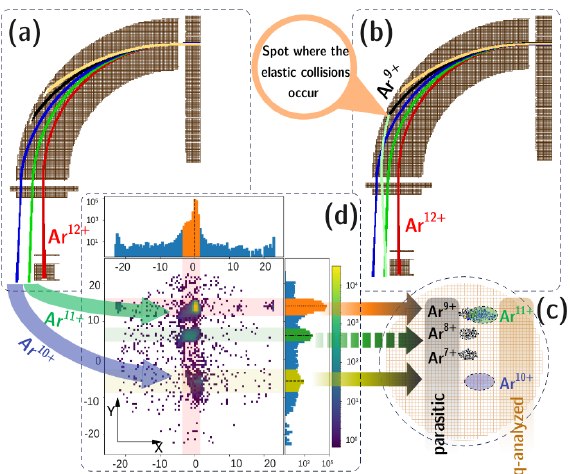
Figure 3. A comparison of SIMION simulations ( a – c ) and experiment ( d ) for the case of Ar 12 + recorded by the Faraday Cup ( a ) with the trajectories of Ar 11 + and Ar 10 + ions alone; ( b ) with the trajectory of the Ar 9 + beam suffering an elastic collision; ( c ) peaks expected on the 2D